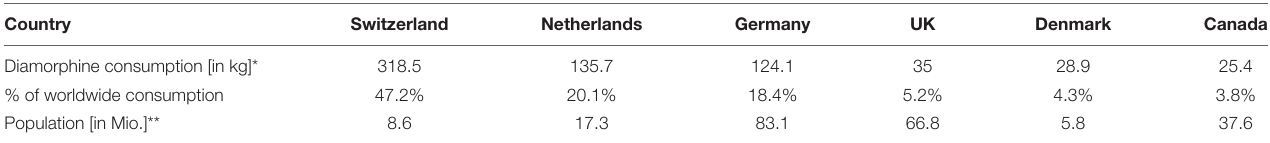
TABLE 1 | Diamorphine consumption and population size of Switzerland, Netherlands, Germany, United Kingdom (UK), Denmark, and Canada in 2019.